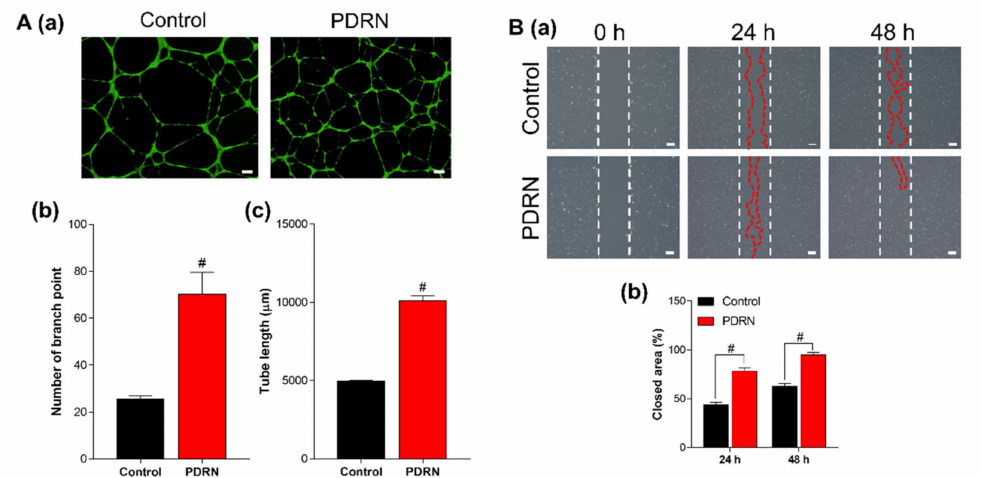
Figure 3. Biological effects of PDRN. ( A ) tubule-forming assay; images of HUVECs stained with calcein AM (scale bar = 200 µ m) ( a ) and quantification of branch point ( b ) and tube length ( c ). ( B ) wound healing assay; optical images (scale bar = 200 µ m) ( a ) and quantification of closed area at 24 and 48 h ( b ). The differences were considered significant when # p < 0.0001 ( n ≥